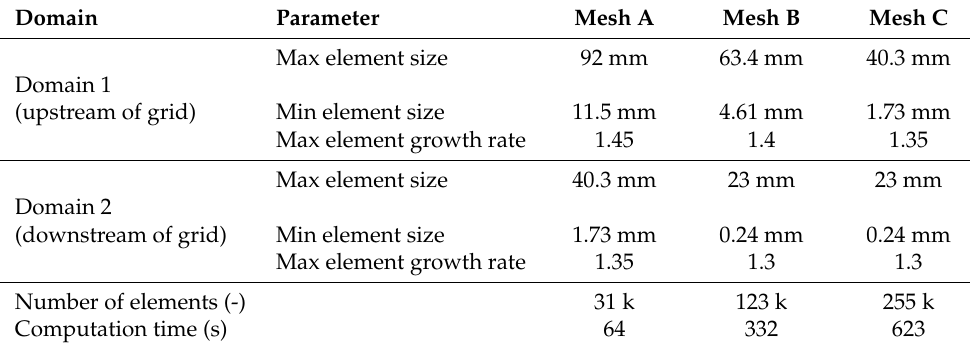
Table 3. Mesh refinement for the FEM simulations in COMSOL.